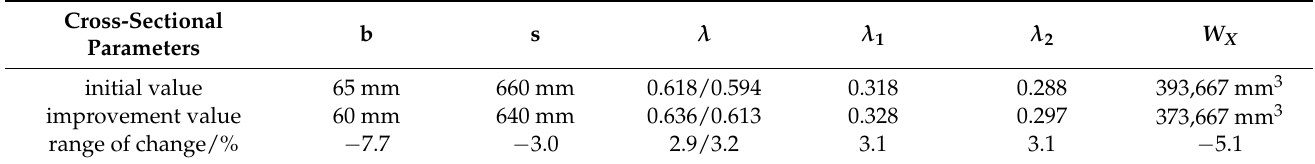
Table 2. Calculation results of section size fine-tuning.